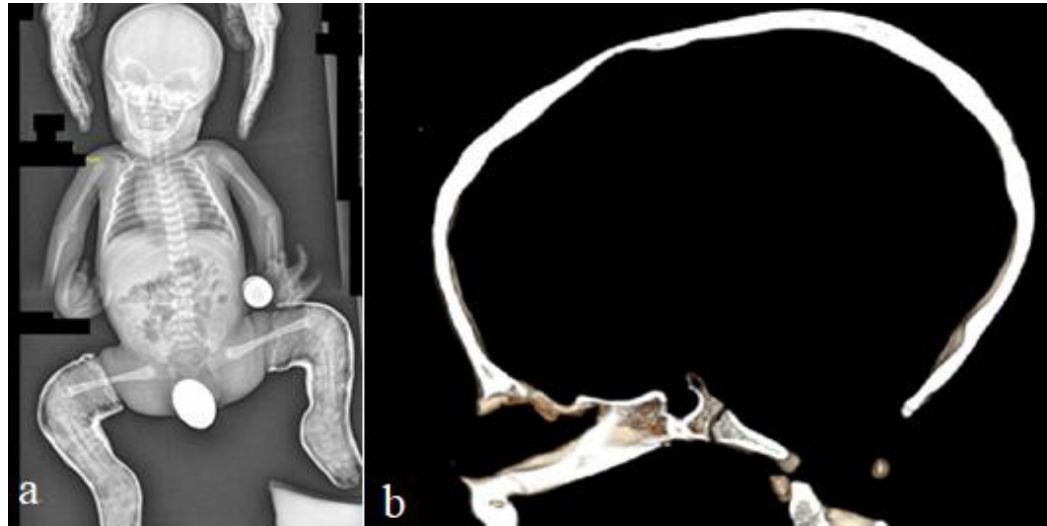
Figure 1. Skeletal survey; general skeletal radiograph at the age of one month showed multiple malformation complexes, starting from the skull and extending downwards to involve the upper and lower limbs, respectively. The skull showed apparent synostosis of the metopic suture. The upper limbs and lower limbs were notably associated with multiple dislocations (hips, wrists, knees, ankle and camptodactyly at the interphalangeal joints). The limb abnormalities were diagnostically important, in that there was a complete anterior dislocation of the tibia and fibula. Treatment was carried out using a plaster cast fixation of the hyperextended knee dislocation and clubfoot, due to the manipulation of the surgeon who, with one hand, held the knee in flexed position, shifting the tibia anterior and pushing the foot into the corrective position ( a ). 3D sagittal cranial CT scan showed craniosynostosis of the metopic suture associated with a well- formed ridge spreading from the metopic suture to involve entire sagittal suture, associated with the obliteration of the anterior fontanelle, with the eventual development of scaphocephaly ( b ).